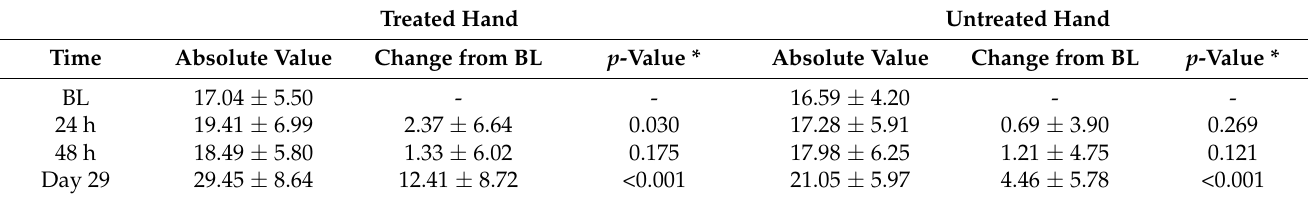
Table 1. Absolute skin surface capacitance values and changes from baseline after a single application of ND-HC (initial 48 h) and after a 4-week application period (at least four times daily). Treated